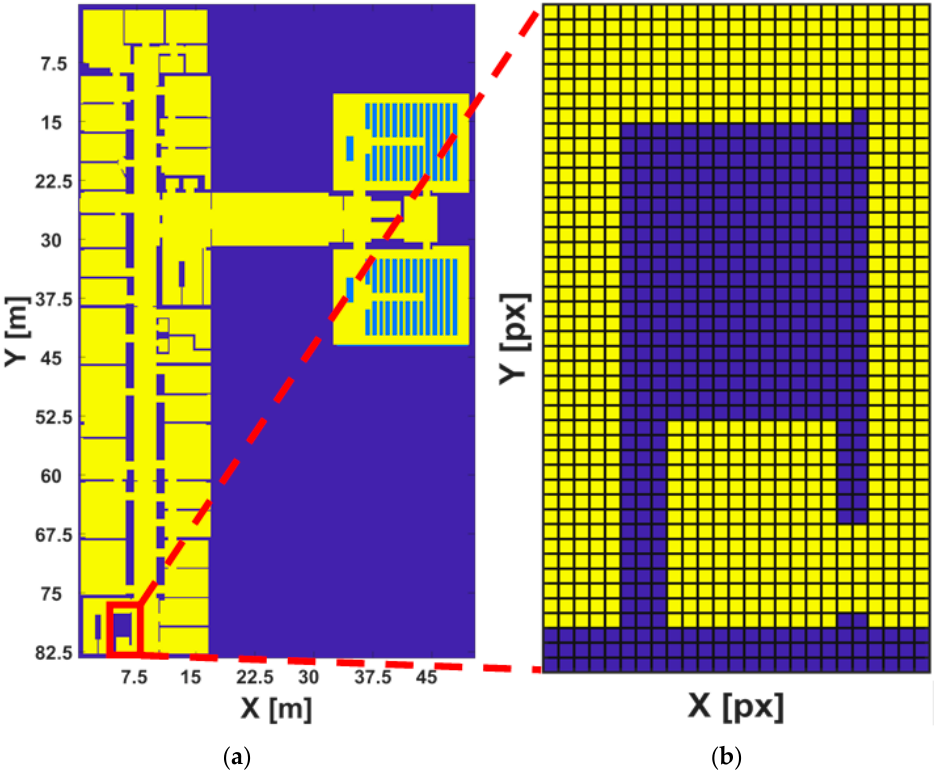
Figure 1. Building model: ( a ) structure of the second floor; ( b ) model section of the grid structure. The walkable indoor areas are represented by yellow pixels, while the areas unlikely to be entered are shown in azure-blue like desks or fixed rows of chairs in the lecture halls. All areas of the building which are not accessible are indicated by blue cells.